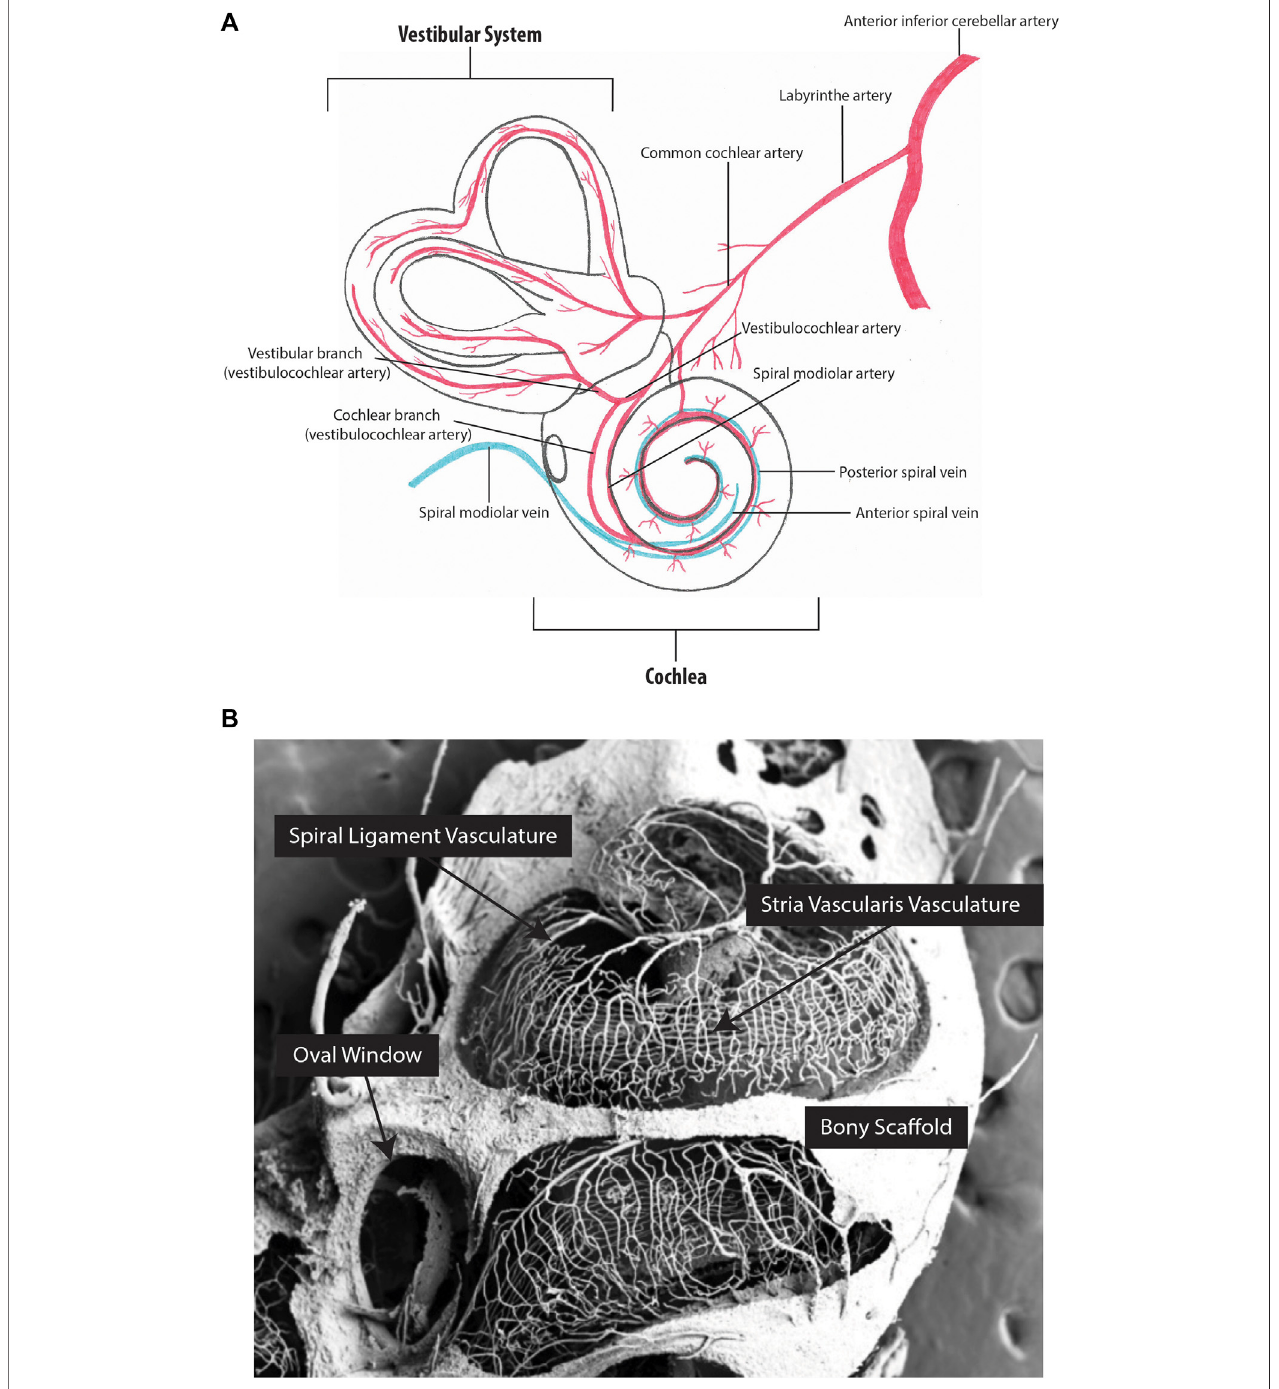
FIGURE 3 | Inner ear vascular network. (A) Arterial blood supply and venous drainage of the cochlear and vestibular systems. (B) Partial corrosion casts of the mouse cochlea. The capillaries of the stria vascularis run parallel along the length of the cochlea. Figure 3B image provided by M. Carraro and R.V. Harrison.